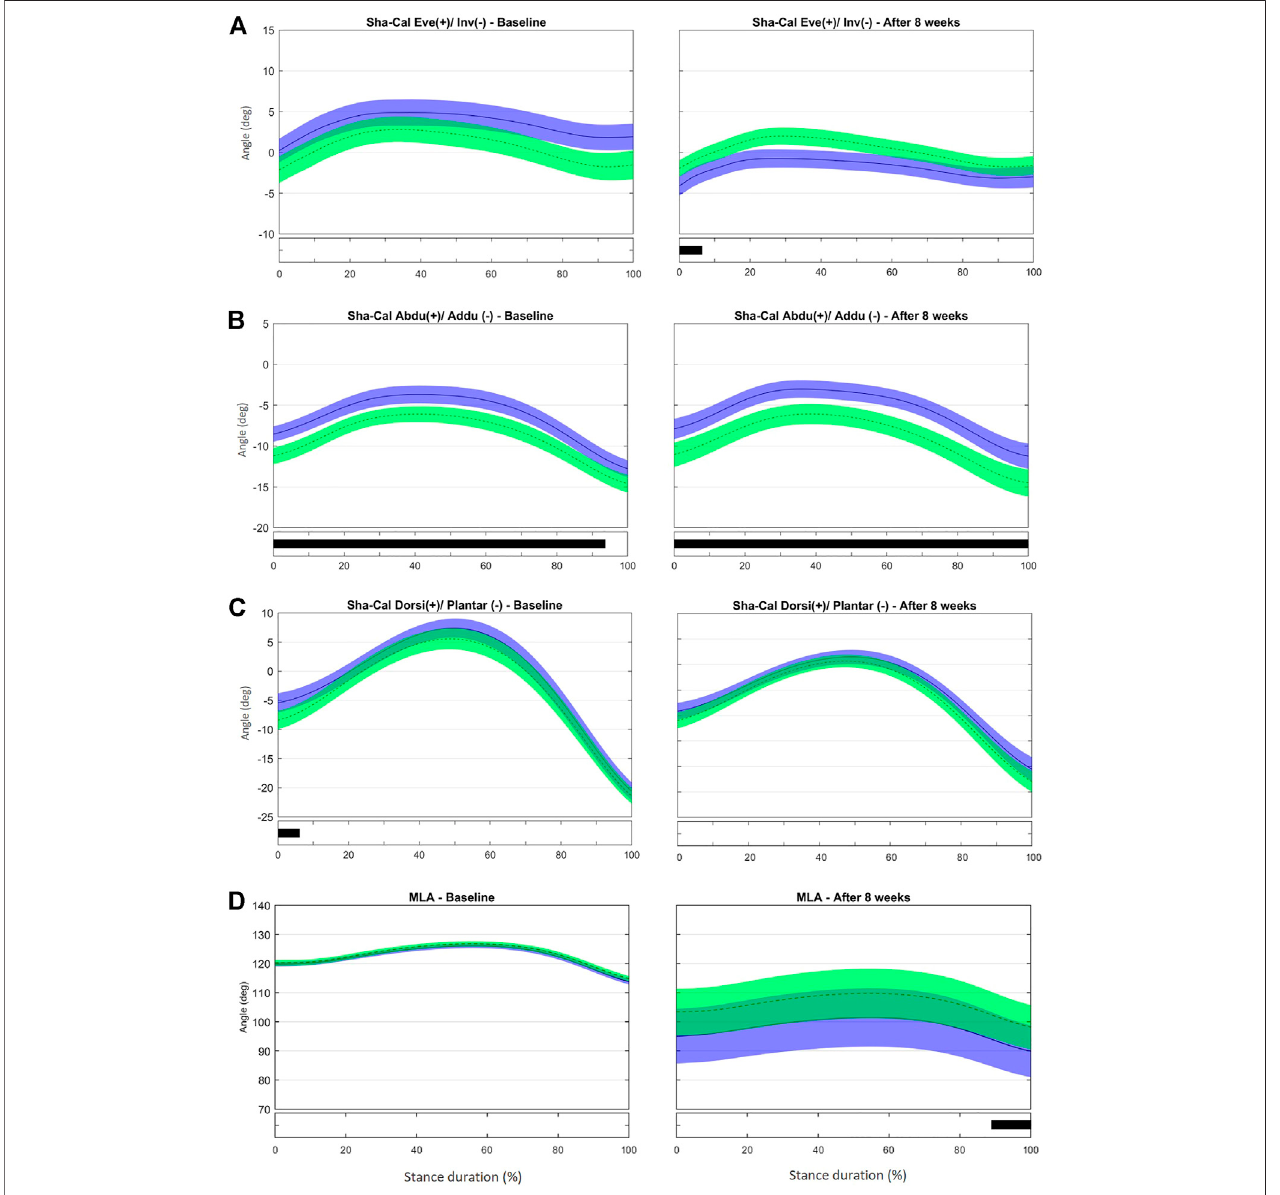
FIGURE5| Mean(±1SD)jointrotationanglesduringnormalizedstancephasedurationofrunninginthebaseline(left)andafter8 weeksofintervention(right).From top tobottom, frontal-plane rotationsbetweencalcaneus and shank (A) , transverse-planerotationsbetweencalcaneus and shank (B) ,sagittal-plane rotationsbetween calcaneus and shank (C) , and medial longitudinal arch angle (D) . Green, CG group; Blue, IG group. The black bar below the graph represents the time during which the differences between the groups occurred ( p < 0.05), what was indicated by the SPM{t} statistics.